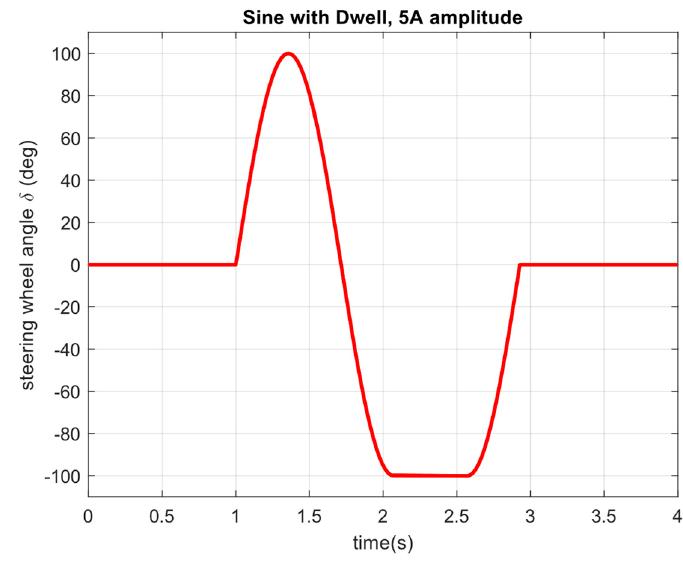
Figure 12. Steering wheel input in the Sine with Dwell stability test.